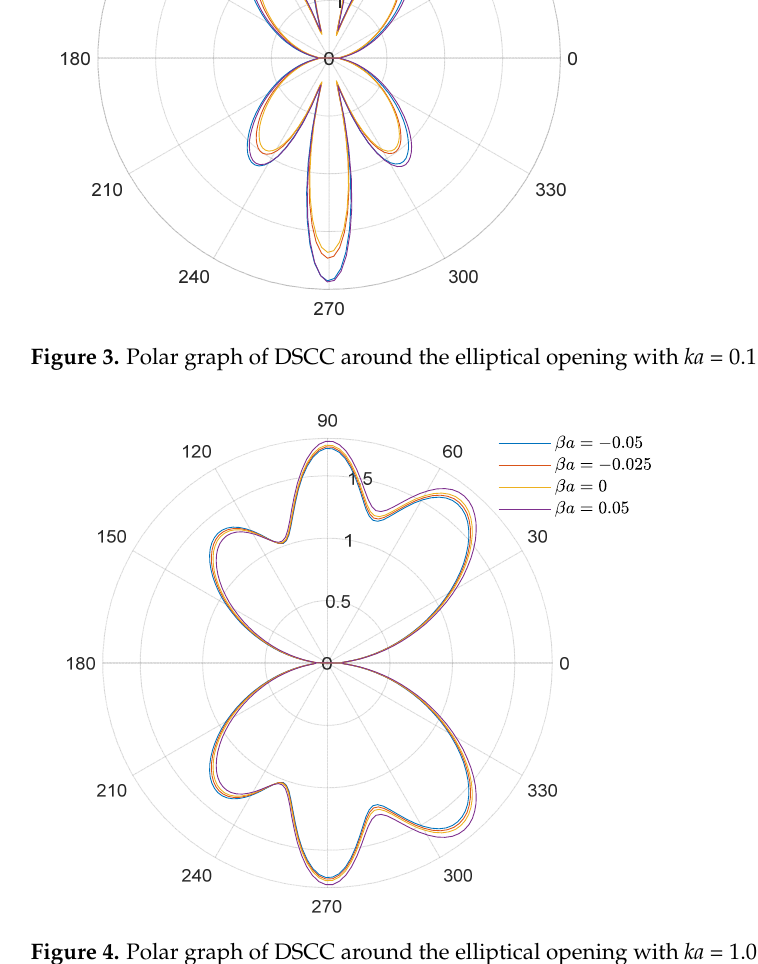
Figure 4. Polar graph of DSCC around the elliptical opening with ka = 1.0 and m = 1/6.